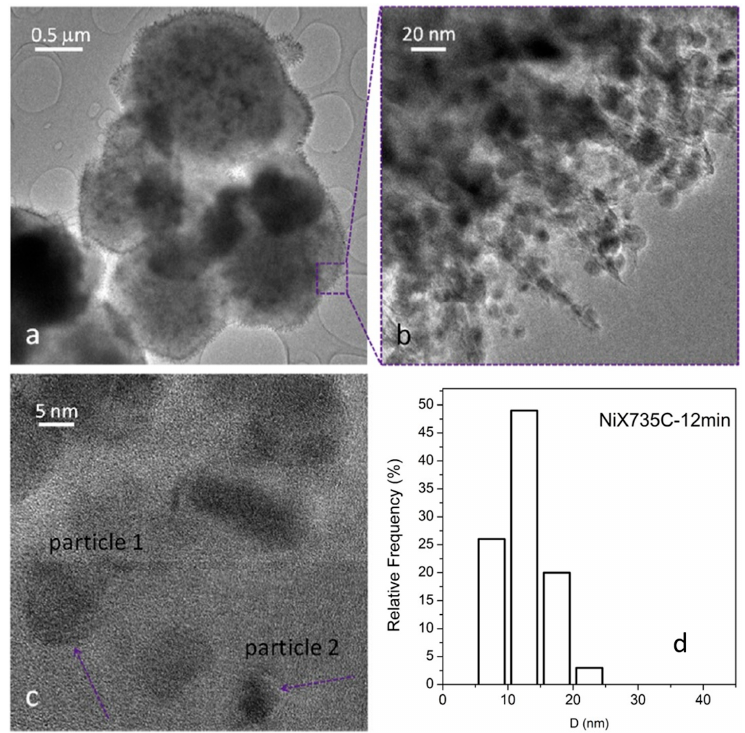
Figure 13. TEM ( a , b ) and HR-TEM ( c ) images of the NiX735C—12 min sample. Instrumental magnification: 4000×, 100,000×, and 400,000×. Reprinted in modified form from the work of [14] with permission from Elsevier. ( d ) Ni particle size distribution.